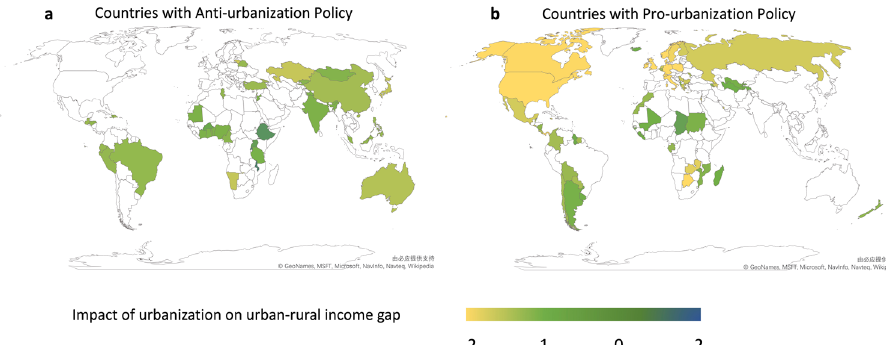
Fig. 8 Impacts of urbanization on the urban-rural gap for country groups with different urbanization policies. a Country group with anti- urbanization policy. b Country group with pro-urbanization policy. This shows the impacts of urbanization on the urban-rural gap for 90 economies in 2015. Clearly, the benign impacts are more signi fi cant in countries with a pro-urbanization policy. Notes: (1) Country grouping is based on “ Policies on Spatial Distribution and Urbanization ” published by the United Nations in 2016. Anti-urbanization is de fi ned as the decentralization of large urban centers to smaller urban, suburban, or rural areas. The counter process is de fi ned as pro-urbanization policy. (2) The impact of urbanization on the urban-rural gap is calculated by the authors (see Methods).